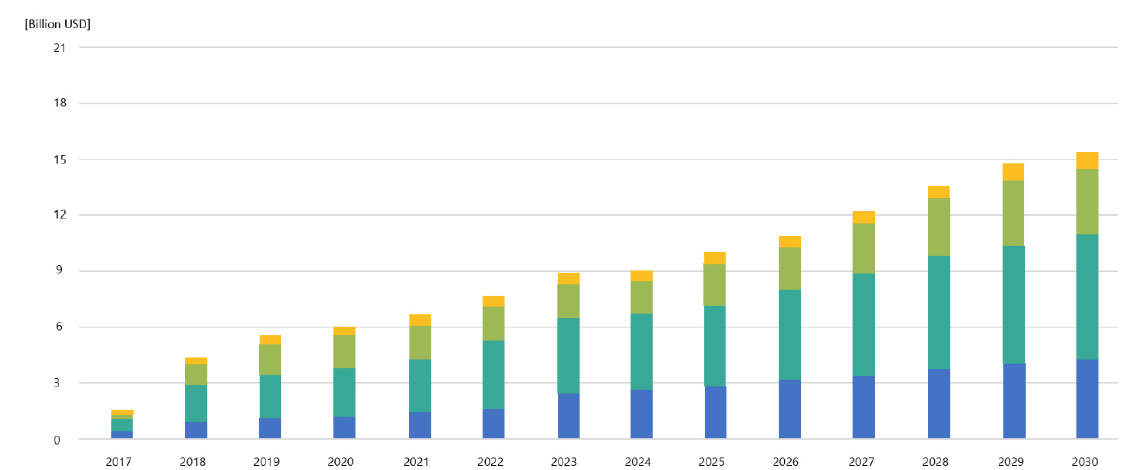
Figure 1. New building market trends of electric propulsion ships (2020, Market Research Report).